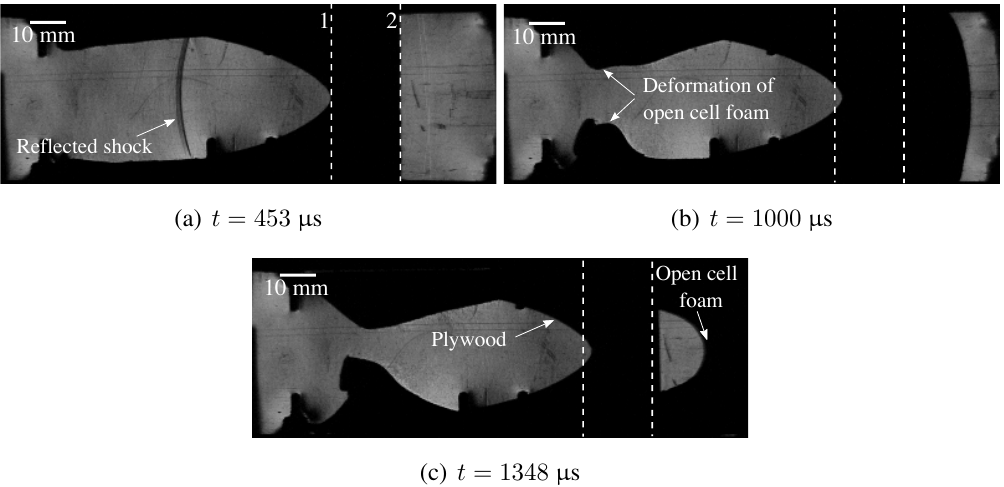
Figure 17. Photographs showing translation and deformation of the 1C open cell foam sample. The dashed Lines 1 and 2 represent the original locations of the tip of the logarithmic spiral and the end of the foam block,